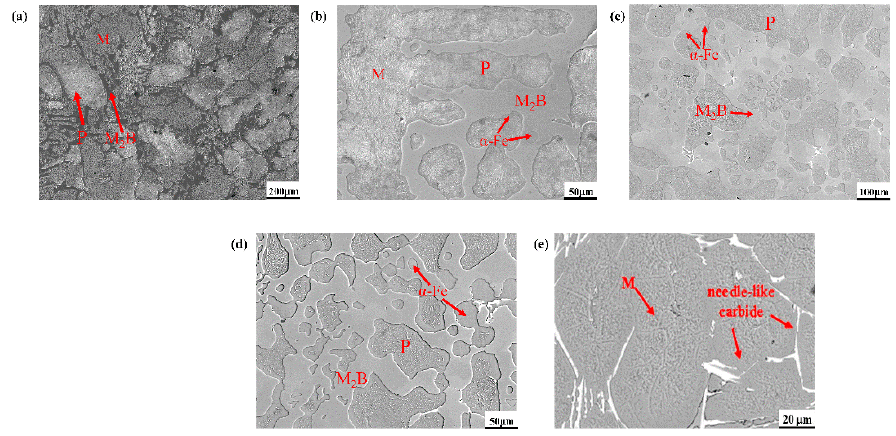
Figure 3. SEM image of high-boron high-speed steel: ( a ) A1, ( b ) A2, ( c ) A3, ( d ) A4, ( e ) M2.